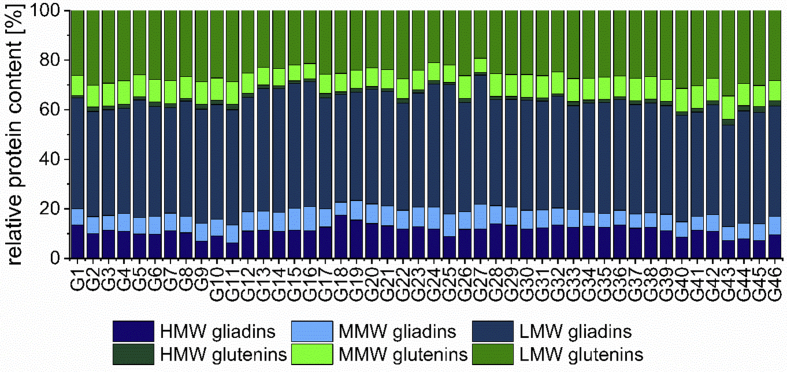
Relative protein content of vital gluten samples G1-G46 determined by GP-HPLC [%]. Data is presented as mean value (n ​= ​3) of relative high-molecular-weight (HMW)-, medium-molecular-weight (MMW)- and low-molecular-weight (LMW)-gliadins and HMW-, MMW- and LMW-glutenins.